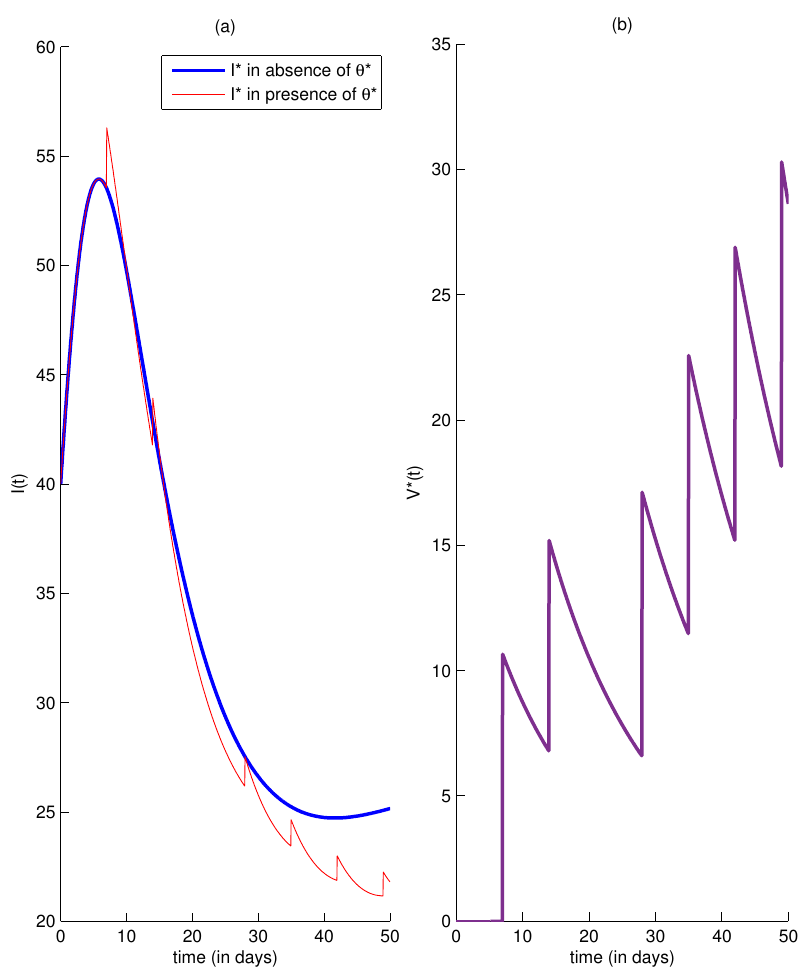
Figure 2. Case ( a ): Number of infected people in the absence and presence of control. Case ( b ): Number of vaccinated people in the presence of control. Same parameters values, initial conditions, and severity weights as in Figure